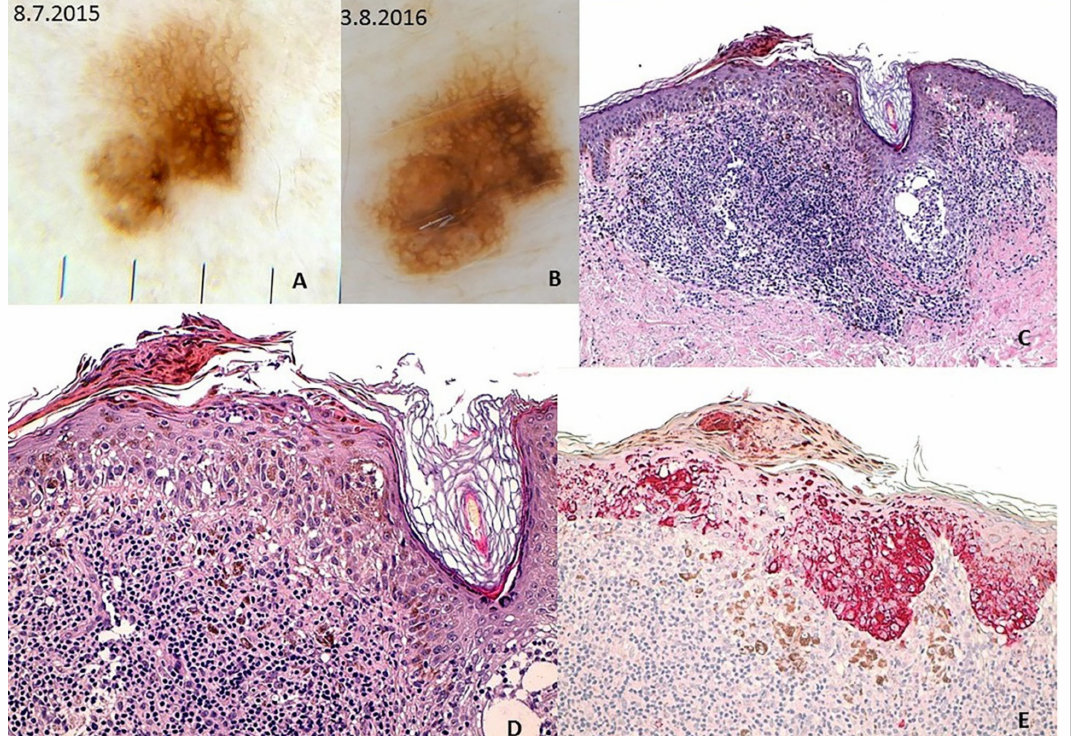
Figure 3. Melanoma in situ on the left flank of a 62-y old man. This small diameter melanoma showed upon polarized contact dermoscopy (Dermaview ® , Tre T Medical, Camposano, NA, Italy) an asymmetric growth at 1-year digital follow-up (Panel A , B ), atypical network, structureless brown areas, and irregular pigmented areas. Histology (Panel C ; HE, × 100) shows a proliferation of atypical melanocytes in single units and nest in all layers of the epidermis and a dense lympho- histiocytic infiltrate with melanophages in the dermis. Pagetoid spread is confirmed also by Melan-A staining (Panel E , 200 × ). The irregular pigmented areas correlate with the clumps of melanin and pigmented parakeratosis (Panel D ; 200 × ); the structureless brown areas correlate with the dense lymphohistiocytic infiltrate with melanophages in the